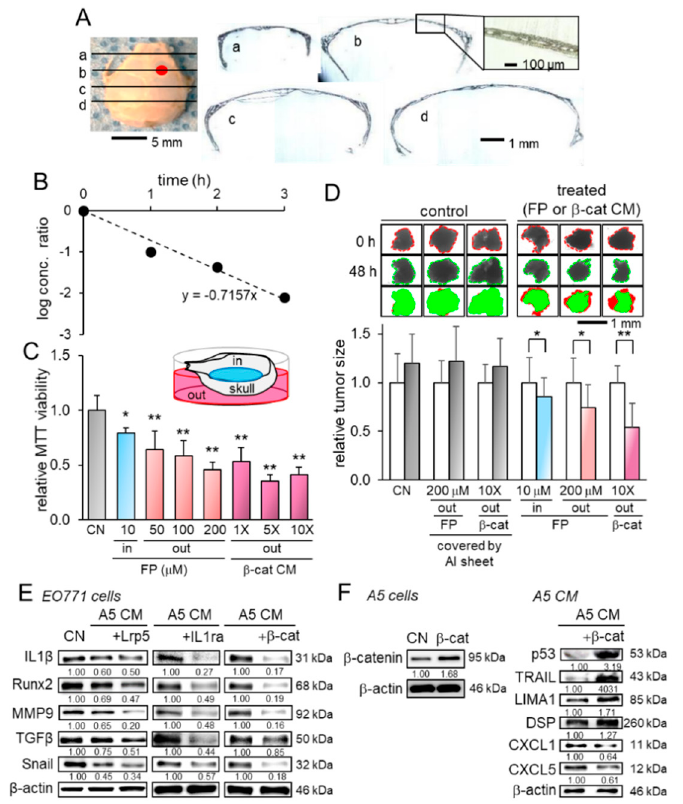
Figure 6. Transport analysis of conditioned medium through the skull and the alterations in gene expression. Of note, FP = fluphenazine, β -cat = β -catenin, CN = control, and CM = conditioned medium. The single and double asterisks indicate p < 0.05 and p < 0.01, respectively. The error bar indicates a standard deviation. ( A ) Coronal sections of the skull. The red mark on the skull image indicates the injection site of EO771 tumor cells. ( B ) Temporal changes in the diffusion-linked ratio (see the derivation in the supplementary information). ( C ) Transport analysis with MTT-based viability, in which EO771 cells were cultured on the inside of the skull. FP and β -catenin-overexpressing CM in the outside of the skull decreased the viability of tumor cells on the inside of the skull. Of note, 10 µ M of FP (an antagonist of dopamine D2 receptor) in the inside of the skull was employed as a positive control for tumor suppression. ( D ) Changes in the size of human mammary tumor fragments. In the control groups, the transport of FP and CM was blocked by the coverage of the skull with Aluminum foil. The administration of FP and CM in the outside of the skull shrunk the mammary tumor fragments in the inside of the skull. Of note, 10 µ M of FP in the inside of the skull was employed as a positive control for tumor suppression. The left and right bars indicate the relative tumor size after 0 and 48 h, respectively. ( E ) Reduction in IL1 β , Runx2, MMP9, TGF β , and Snail in EO771 cells by osteocyte-derived CM with and without the overexpression of Lrp5, IL1ra, and β -catenin. ( F ) Overexpression of β -catenin in osteocytes, and the elevation in p53, TRAIL, LIMA1, and DSP, as well as the reduction in CXCL1 and CXCL5 in osteocyte-derived CM by the overexpression of β